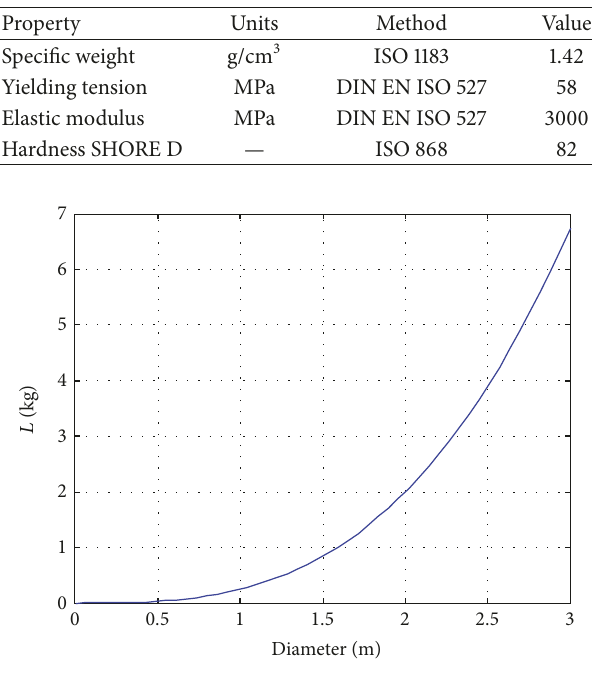
Figure 8: Gross static lift versus balloon